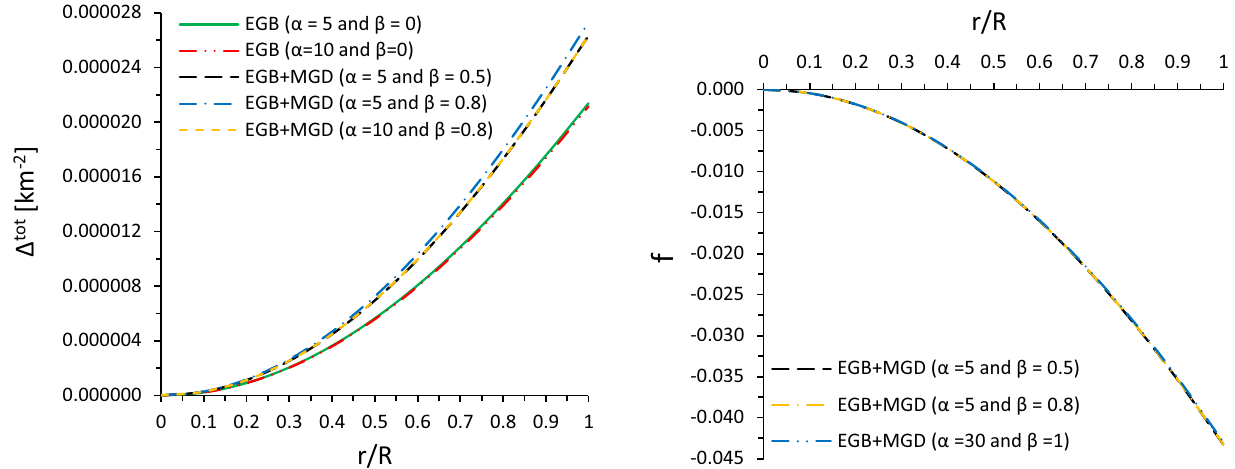
Fig. 5 The variation of total anisotropy [ (cid:22) tot = 8 π( P ⊥ − P ) ] and deformation function ( f ( r ) ) versus radial coordinate r / R . Here, we use the same set of parameters as of Fig. 2